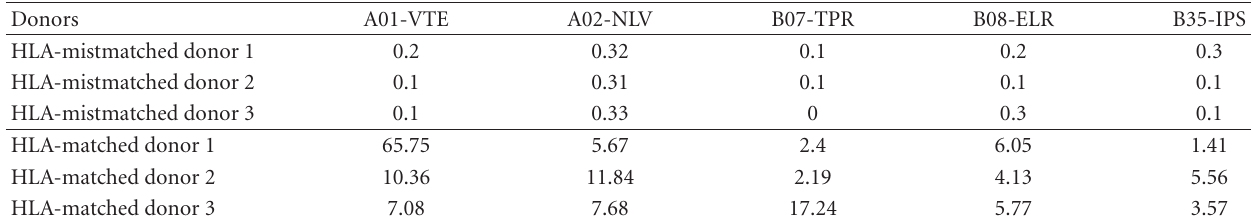
Table 5: Specificity of tetramer staining. Values represent number of cells per mL of blood.